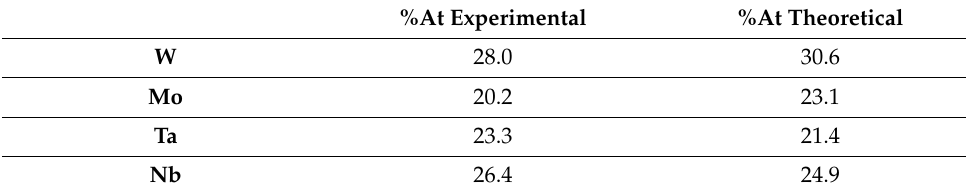
Table 1. X-ray fluorescence analysis on WMoTaNb powder prepared by SHS.